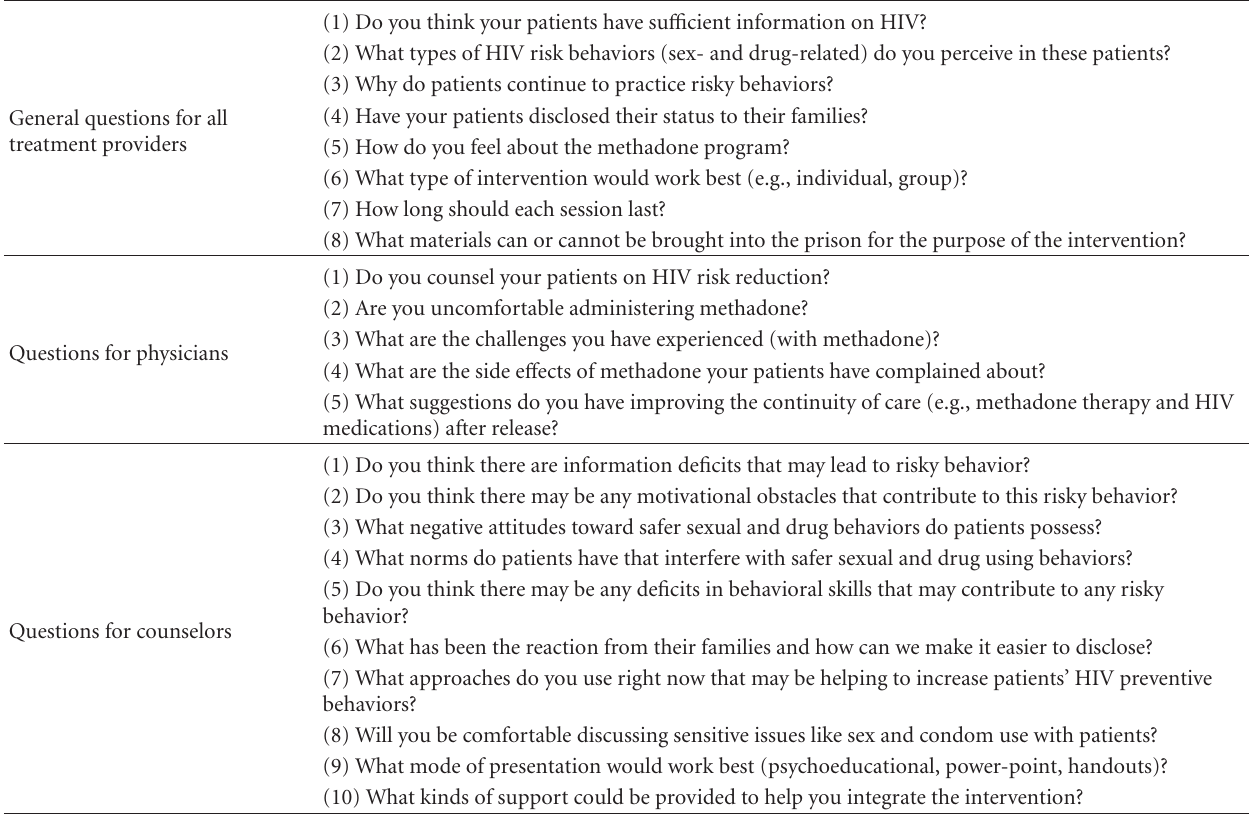
Table 2: Interview instrument for treatment